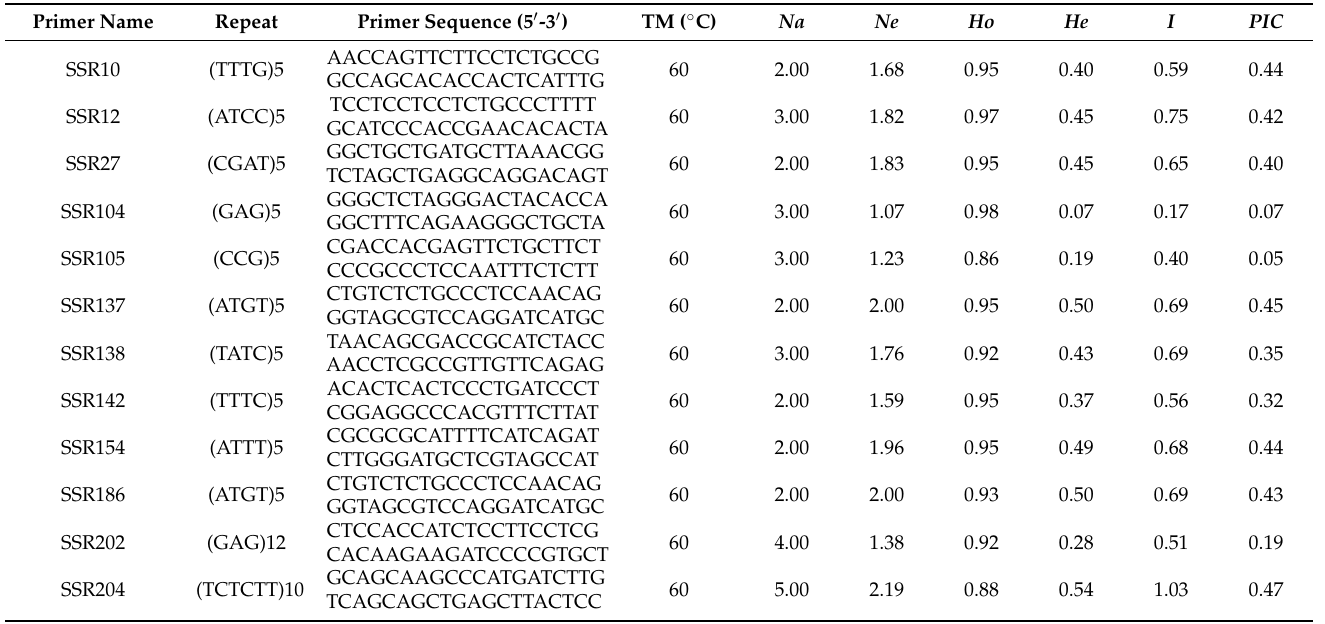
Table 3. Characteristics of 14 selected EST-SSR markers in E. indica